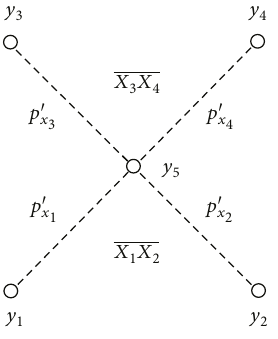
Figure 7: Illustration of two MVI terms with a common